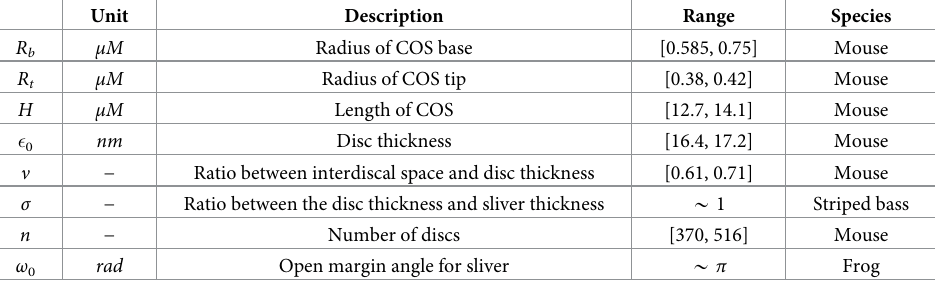
Table 1. Geometric parameters for the mouse cone outer segment